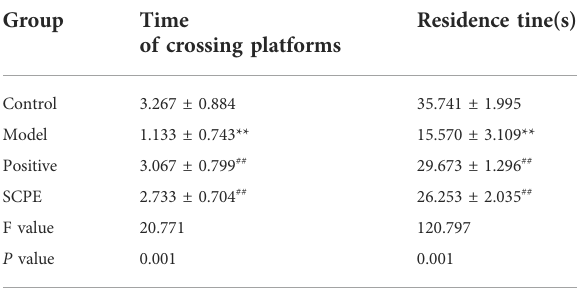
TABLE 2 Effect of SCPE on space exploration of D-galactose model mice (mean ± SD, n = 15). Group Time of crossing platforms